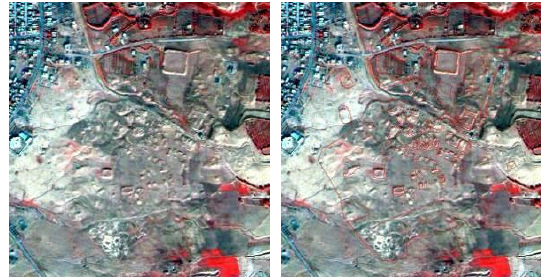
Figure 14 - Makhmúr al-Qadíma - a NIRGB synthesis of the FORMOSAT-2 images (acquired on 2 11. 2014) with an overlaid objects of interest on the left